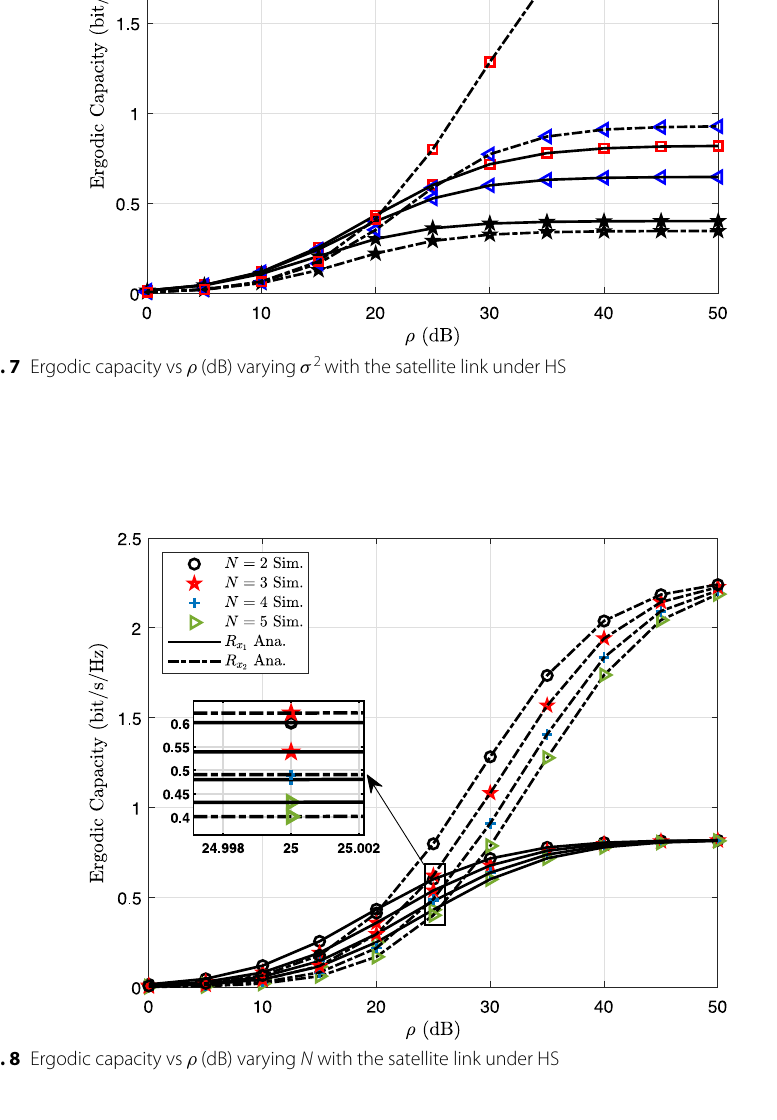
interference links does not show much differential effect on ergodic capacity rates.